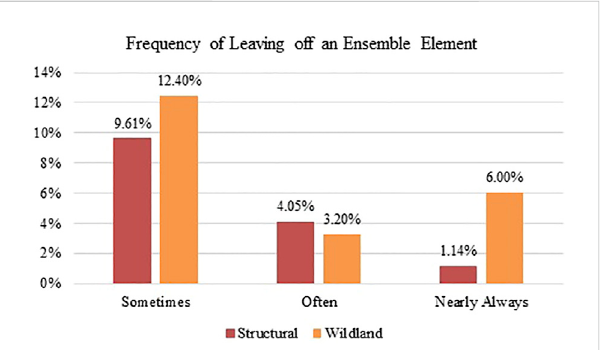
FIGURE 4 Percentage of structural and wildland female fi re fi ghters who “ sometimes ” , “ often ” , or “ nearly always ” leave off apart of their turnout or wildland gear due to improper fi